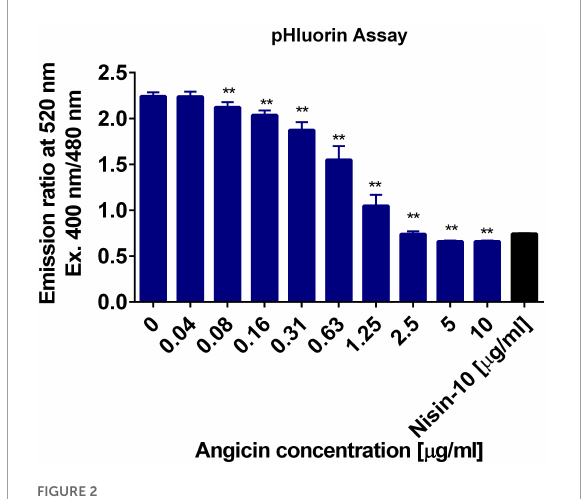
FIGURE2 Membrane damaging activity of Angicin on Listeria monocytogenes . L. monocytogenes EGD-e/pNZ-P help -pHluorin was incubated with Angicin concentrations ranging from 0.04 to 10 µ g/ml in LMB, pH 6.2. Untreated bacteria were used as a negative control and Nisin (10 µ g/ml) treated bacteria as positive control. Depicted is the mean + standard deviation of 2 independent experiments, each with three independent cultures. A Mann-Whitney- U -test was used to calculate significant differences to the negative control, with ** showing a p -value < 0.01.